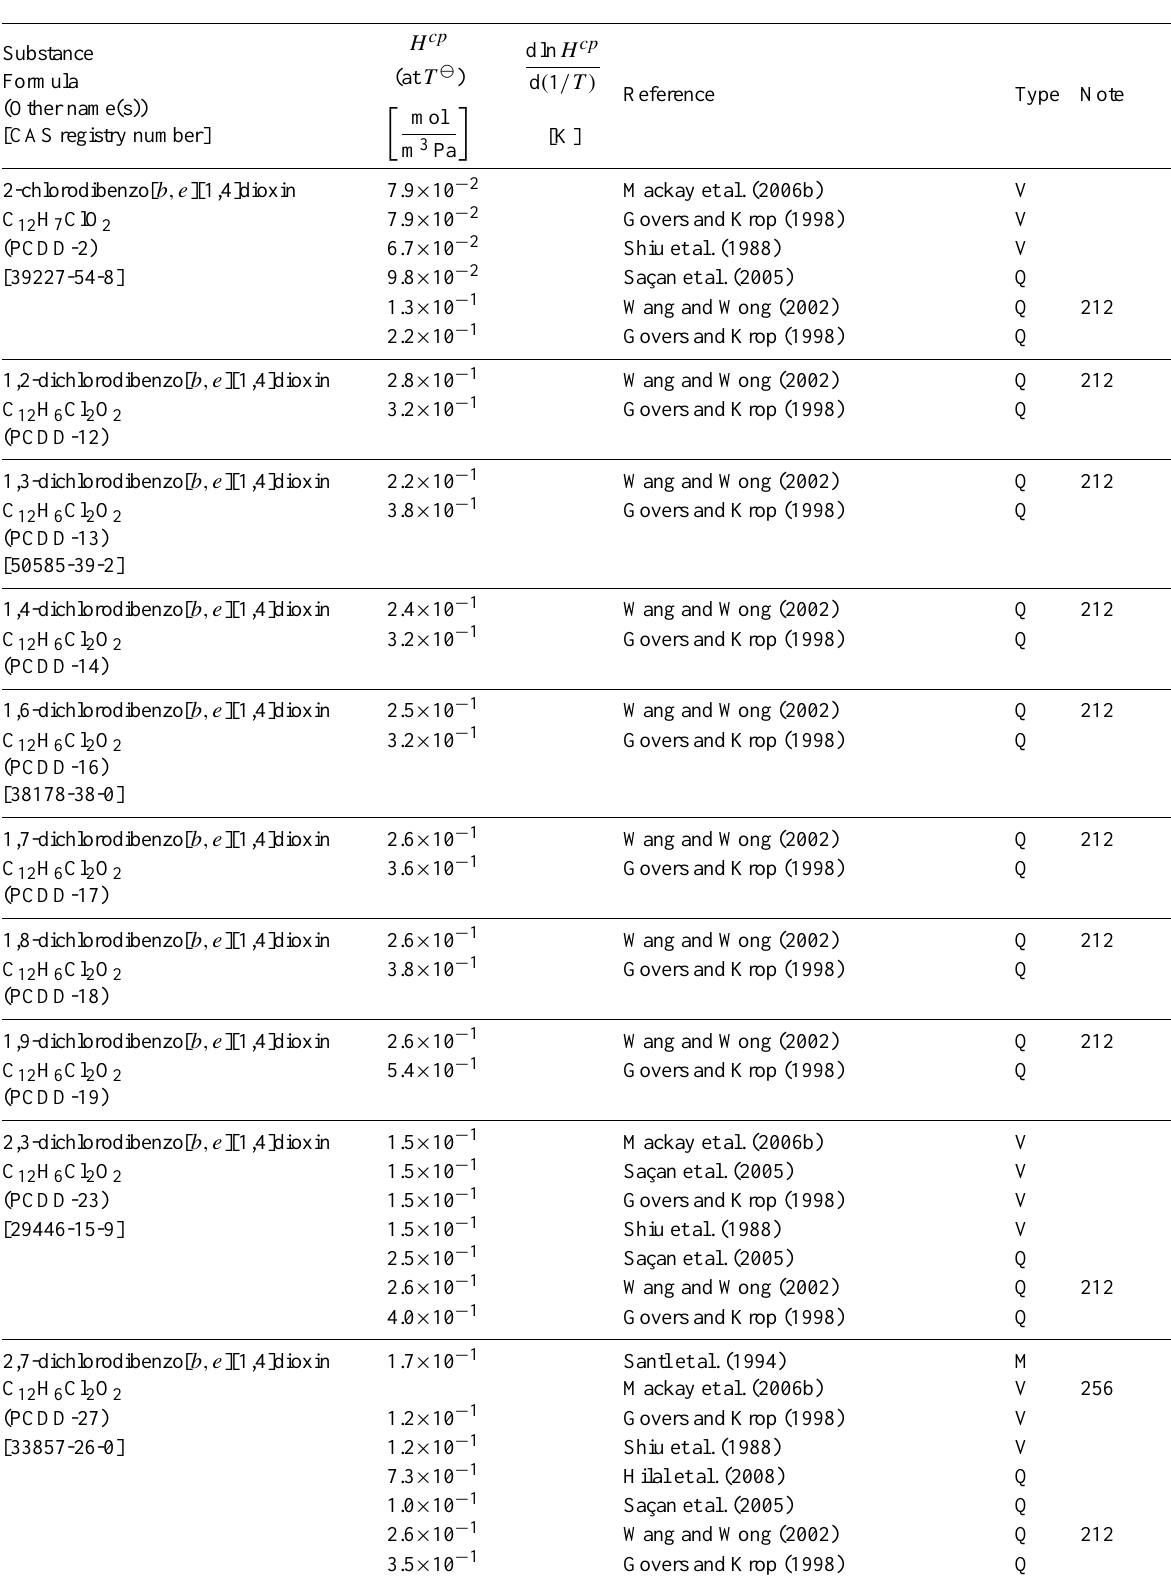
Table 6: Henry’s law constants for water as solvent